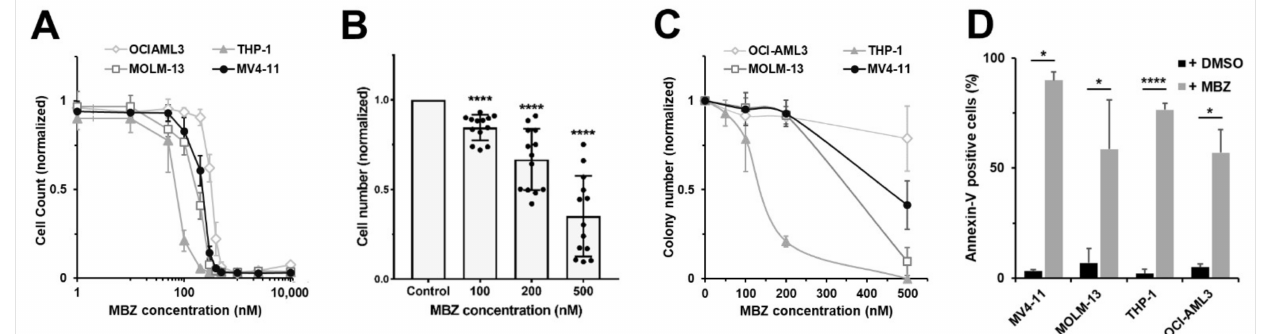
Figure 5. MBZ induces apoptosis and growth inhibition of AML cells. ( A ) Effects of increasing MBZ doses on AML cell lines MV4-11, MOLM-13, THP-1, and OCI-AML3 were analyzed for proliferation after three days. ( B ) Cell growth of primary AML cells ( n = 13) was determined after 7 days of MBZ treatment. ( C ) Clonogenicity of AML cell lines MV4-11, MOLM-13 and THP-1 with increasing MBZ doses was investigated in colony formation assays. ( D ) Apoptosis induction was measured at 48 h after MBZ treatment in AML cell lines. Error bars represent the mean values ± standard deviation. * p < 0.05, **** p < 0.0001 in the Welch’s t -test.